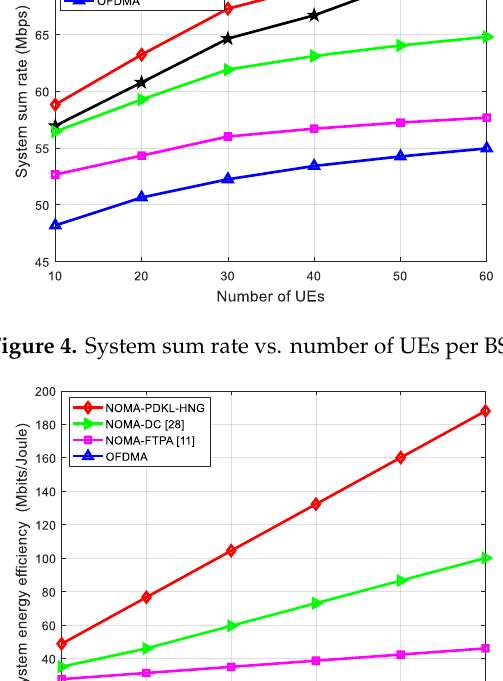
Figure 5. System energy efficiency vs. number of UEs.